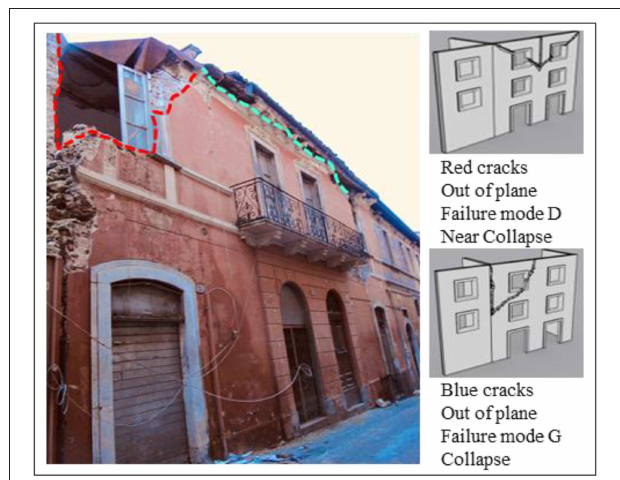
FIGURE 4 | CERTAIN failure modes associated to different crack patterns identified on